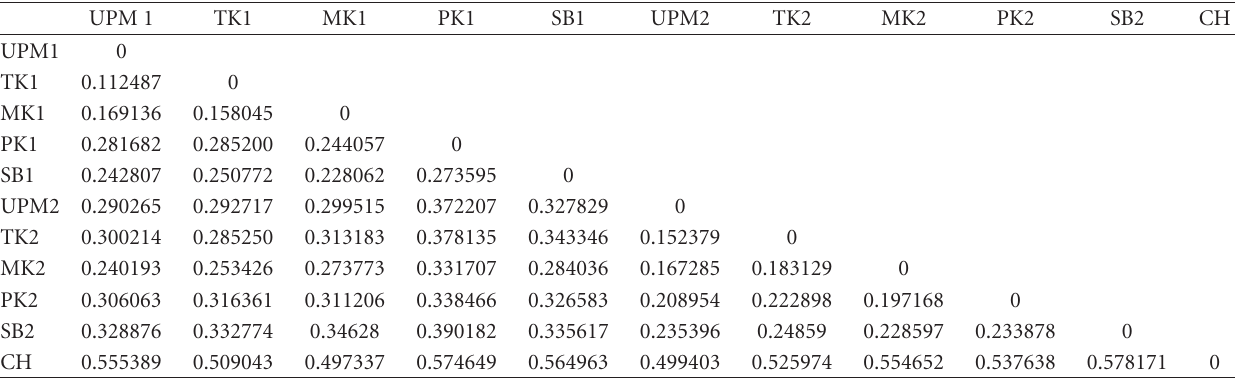
Table 5: Analysis of molecular variance (AMOVA) of 10 populations of N. lugens based on three DALP primers. Primer